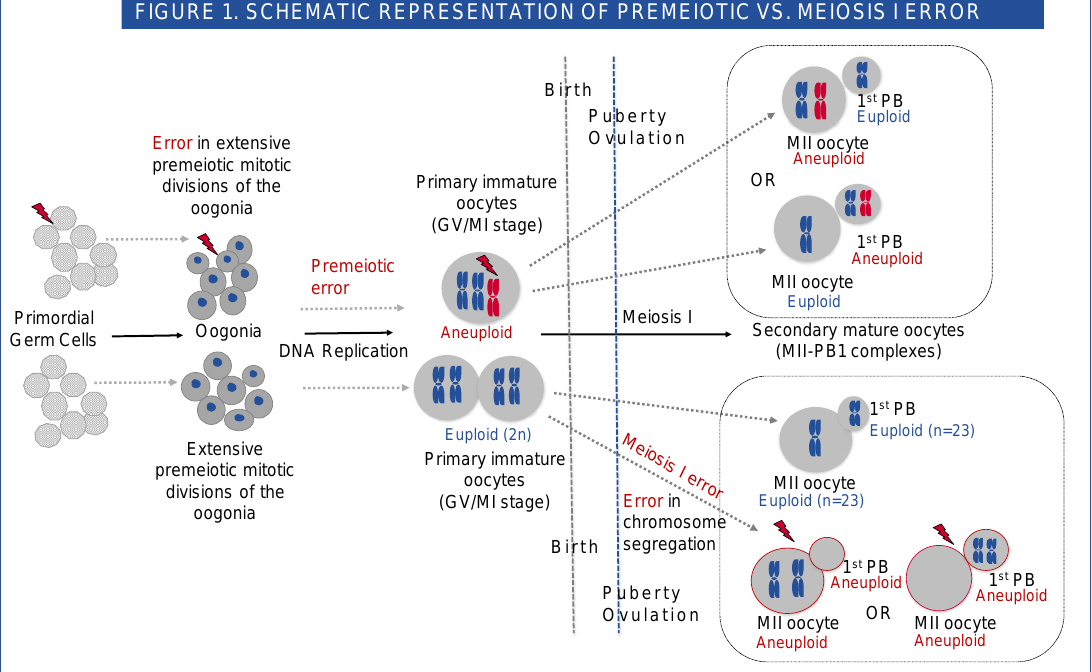
FIGURE 1. SCHEMATIC REPRESENTATION OF PREMEIOTIC VS. MEIOSIS I ERROR